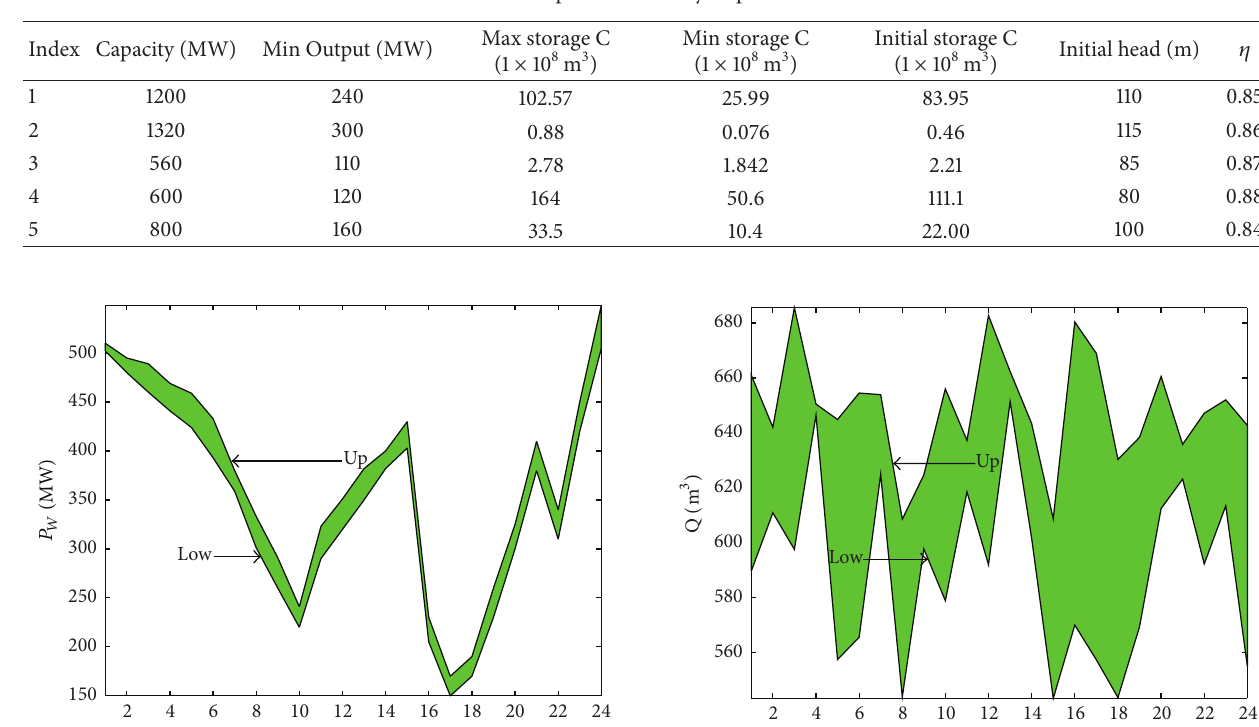
Table 2: Basic parameters of hydropower stations.